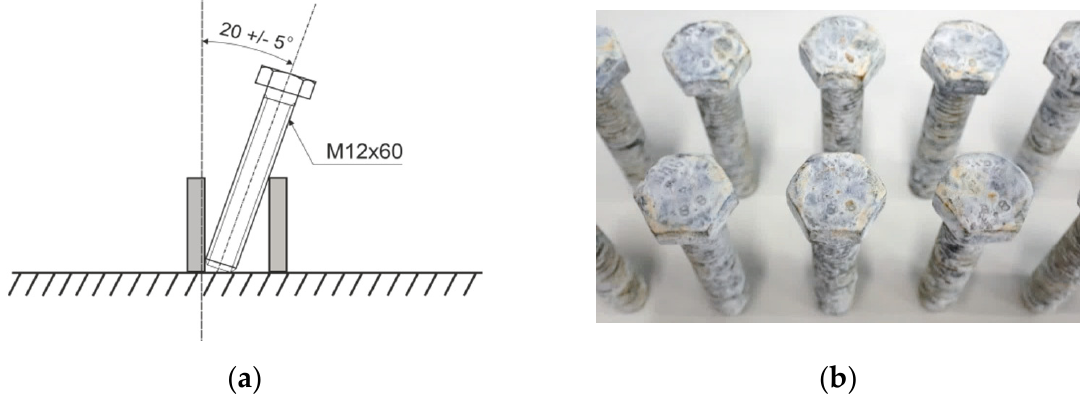
Figure 4. Bolt position during the NSS test ( a ) and their appearance after the test ( b ). Bolts were subjected to an accelerated corrosion resistance test in a neutral salt spray (NSS). The parameters of accelerated corrosion tests in the salt chamber were as